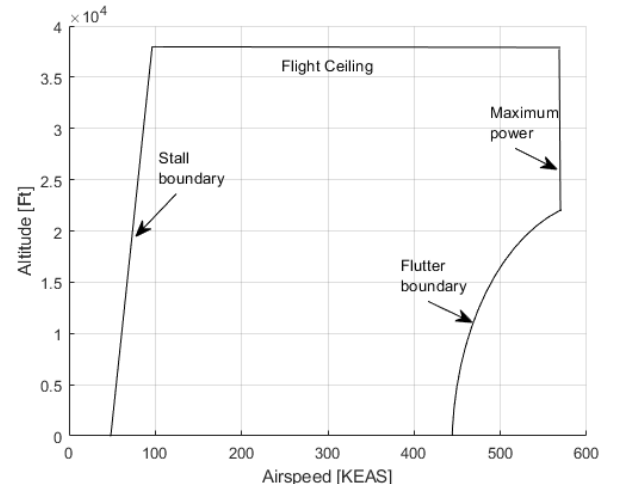
Figure 1. Depiction of a typical flight envelope. In this sample case the flutter boundary defines the low altitude-high airspeed right boundary, while the high altitude and high airspeed boundaries are defined by the wing surface and maximum available power. However, different aircraft may present different boundaries produced by other aeroelastic phenomena.